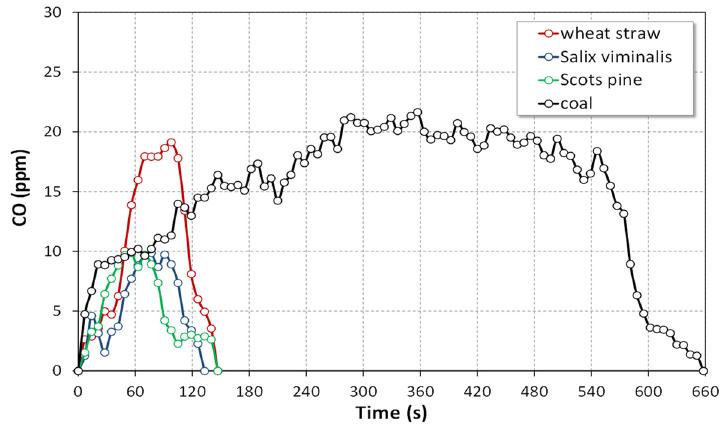
Figure 7. Effect of fuel type on the instantaneous CO concentrations during air